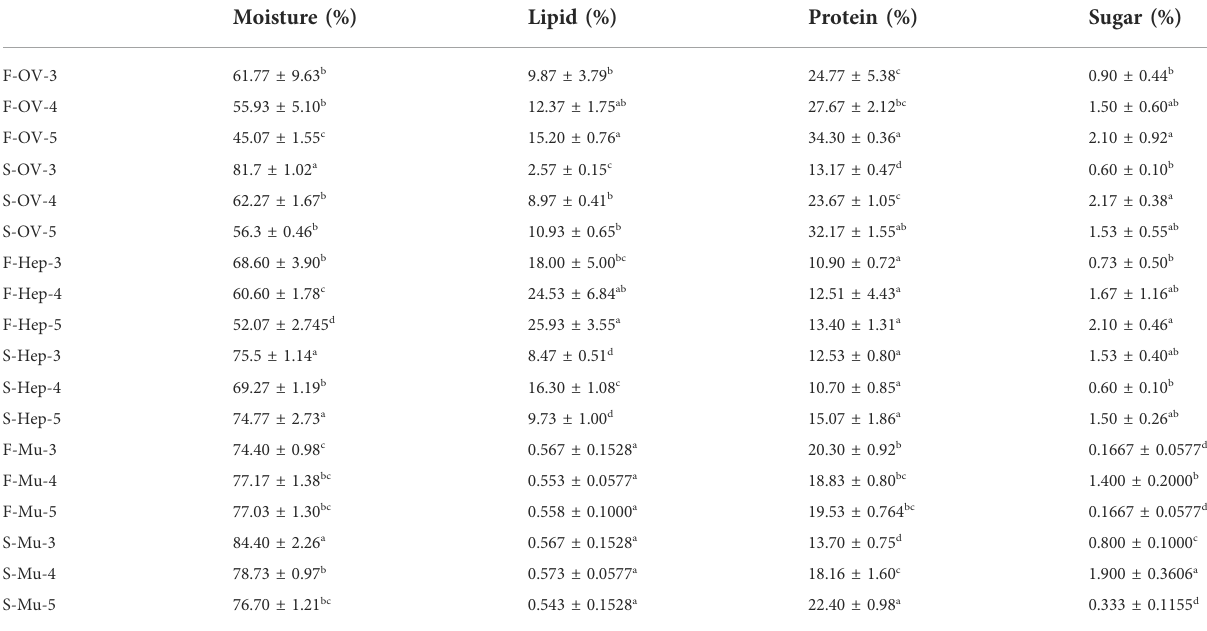
TABLE4Theproximatecompositionsintheovary,hepatopancreas,andmuscleoffemale Scyllaparamamosain